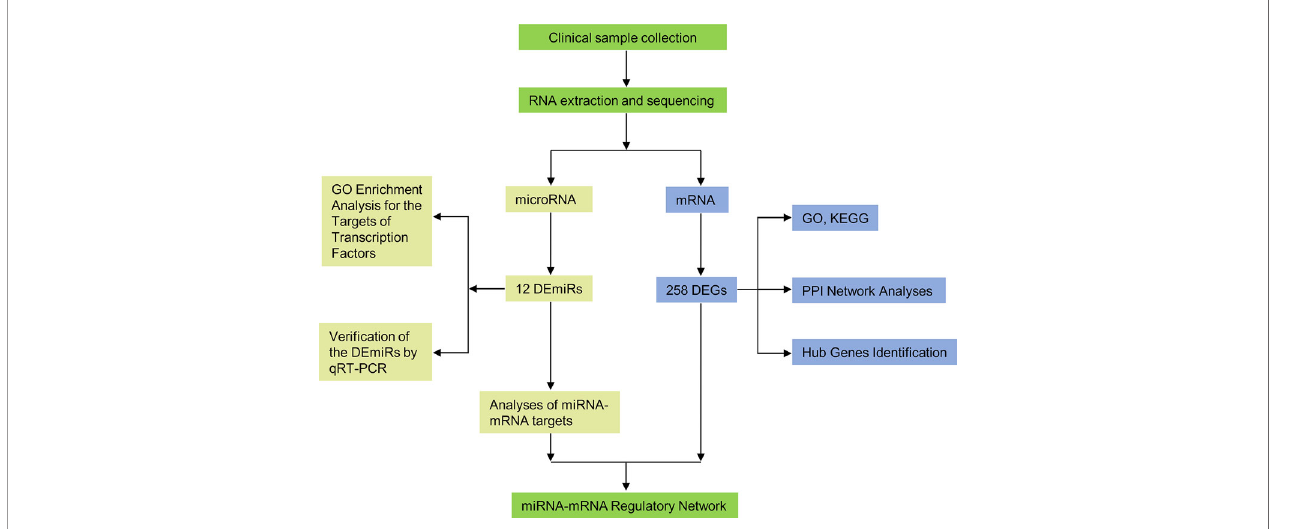
FIGURE 1 | Flow diagram of the study design. DEmiRs, differentially expressed miRNAs; DEGs, differentially expressed genes; GO, Gene Ontology; KEGG, Kyoto Encyclopedia of Genes and Genomes; PPI, protein-protein interaction.